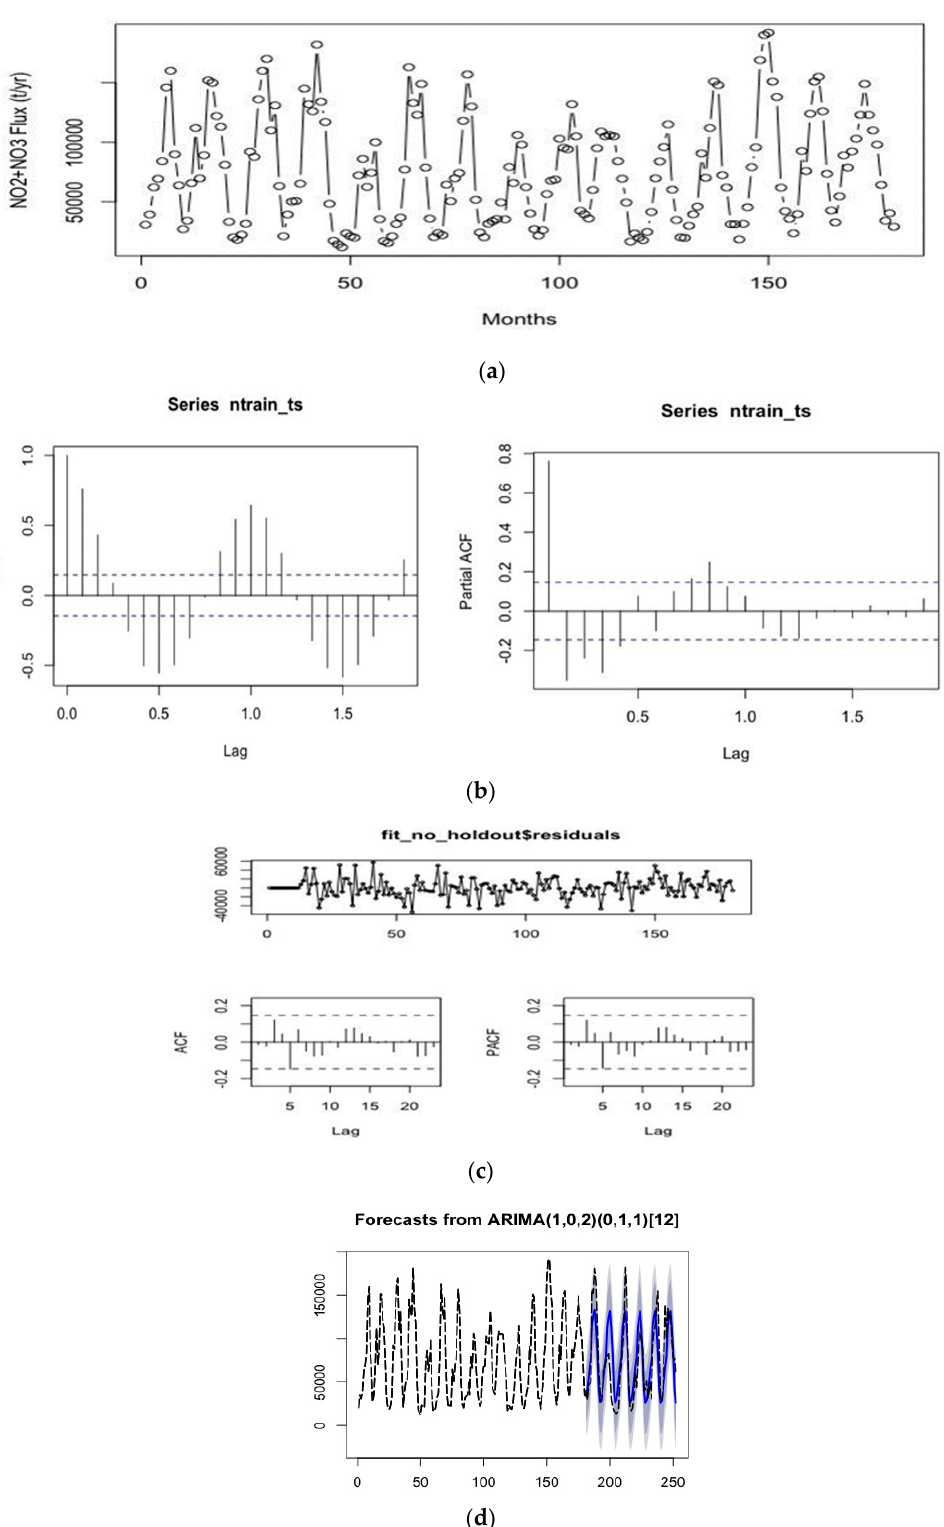
Figure 6. Results of the autoregression integrated moving average (ARIMA) analysis of NO 2 − + NO 3 − data. ( a ) Monthly observations of the NO 2 − + NO 3 − load in the Mississippi River; ( b ) ACF and PACF plots of the training data; ( c ) residual plot of ARIMA (1,0,2) × (0,1,1) 12 ; and ( d ) model forecast for mean monthly nutrient NO 2 − + NO 3 − loads from October 2010 through September 2016.